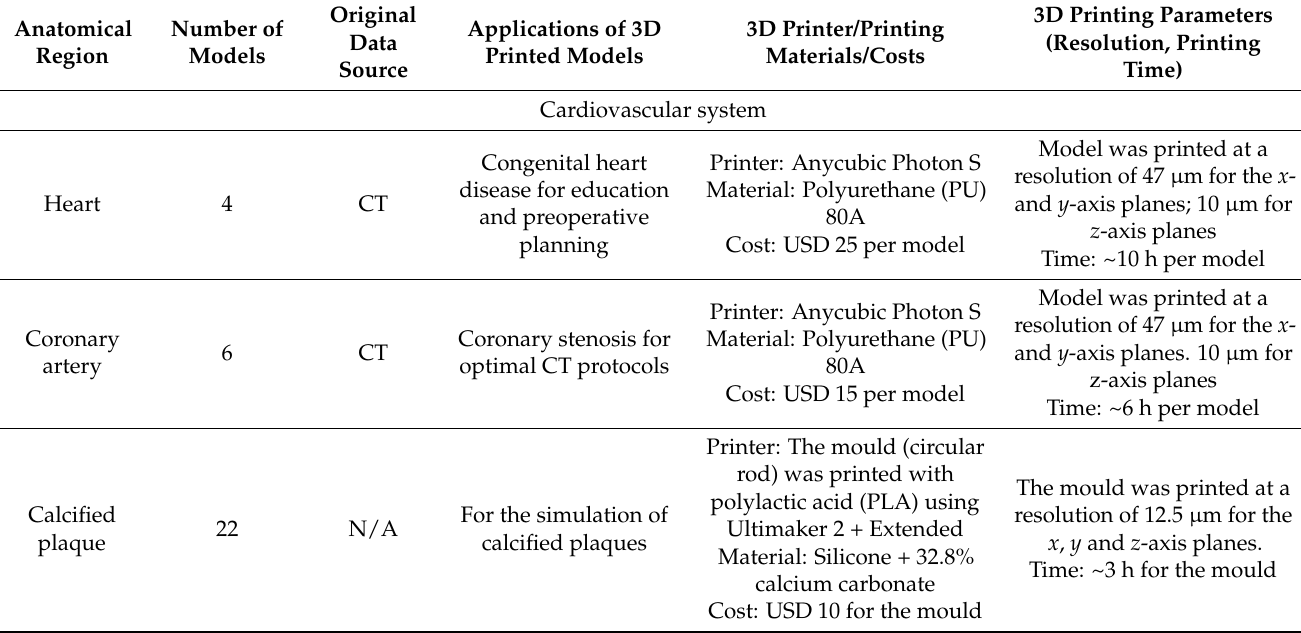
Table 1. List of 3D-printed models that were printed with different printers and materials for medical